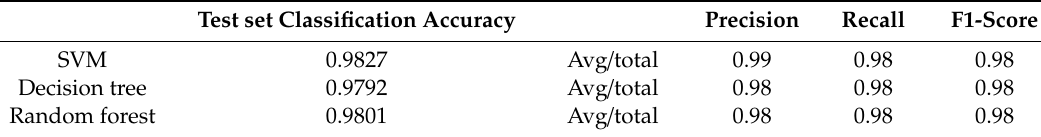
Table 7. Three classifier experimental results of multiple classification